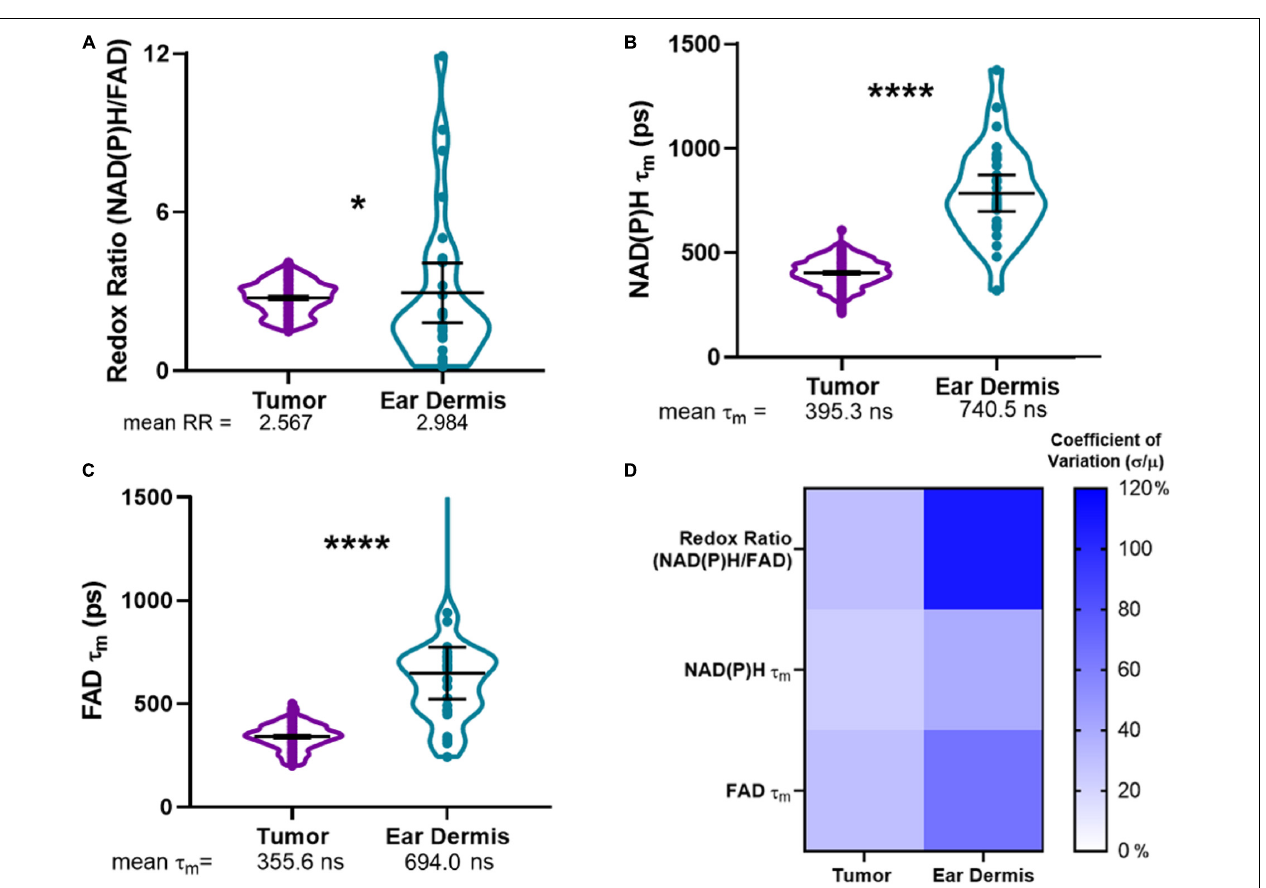
FIGURE 3 | Metabolic autofluorescence resolves differences between tumor and dermal macrophages. (A–C) Violin plots show the full distributions of optical redox ratio (RR), NAD(P)H τ m , and FAD τ m measured from individual macrophages in tumor and dermal tissues. Mean ± 95% confidence intervals for each measurement are represented by thick black lines and error bars, respectively, overlaid on the violin plots. (A) Quantitative single-cell analysis of redox ratio reveals that tumor-infiltrating macrophages are more oxidized than non-malignant dermal macrophages (2.567 ± 0.53 tumor RR vs. 2.984 ± 0.905 dermis RR). Additionally, mean lifetimes ( τ m ) of (B) NAD(P)H and (C) FAD are lower in tumor-infiltrating macrophage populations compared to non-malignant dermal macrophages. (*, **** p < 0.05, 0.0001; n = 4 mice, 836 cells – tumor; 52 cells – ear dermis). (D) Heatmap of coefficients of variation for autofluorescence variables demonstrate macrophage heterogeneity across both tissues, with the greatest variation observed across ear dermis macrophages. Percent coefficients of variation were calculated as the measurement standard deviation ( σ ) divided by the measurement mean ( µ ) multiplied by 100 for each variable and tissue